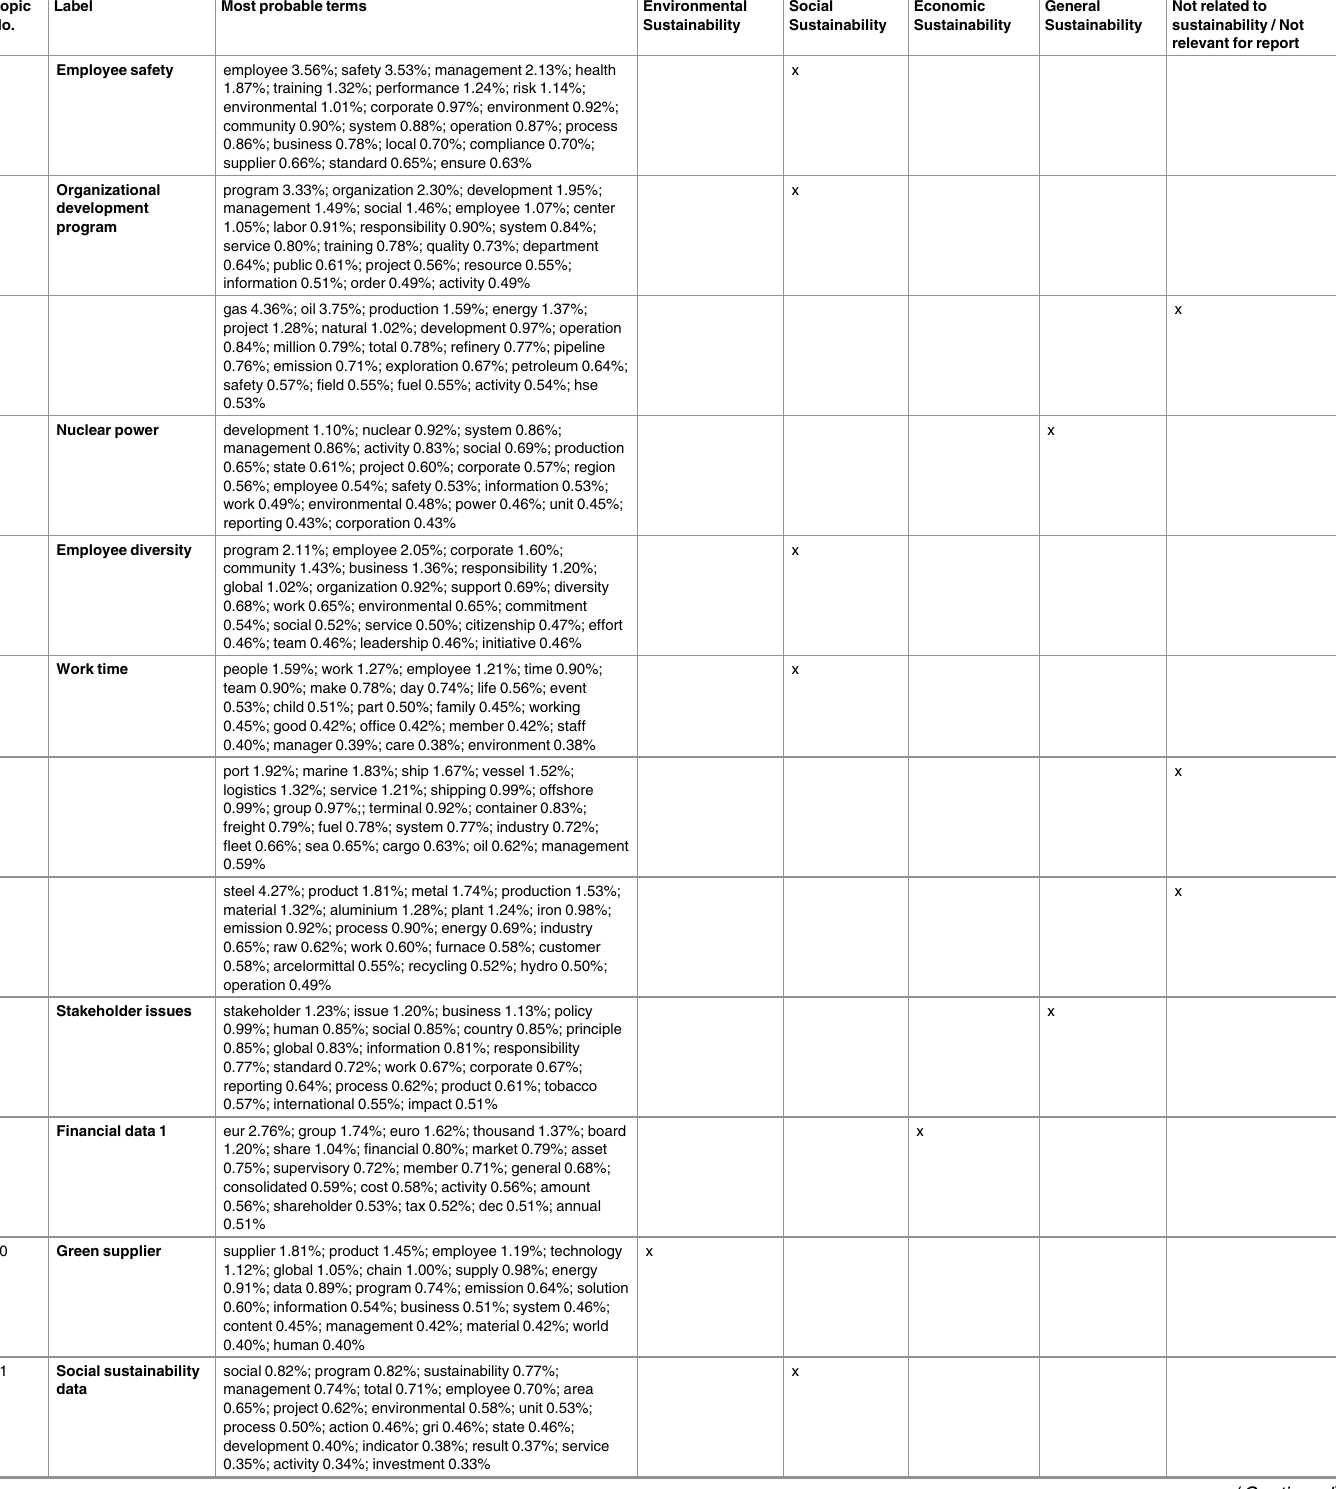
Table 7. Overview on all 70 topics including the twenty most occurring ordered by their probability of occurrence. Topic